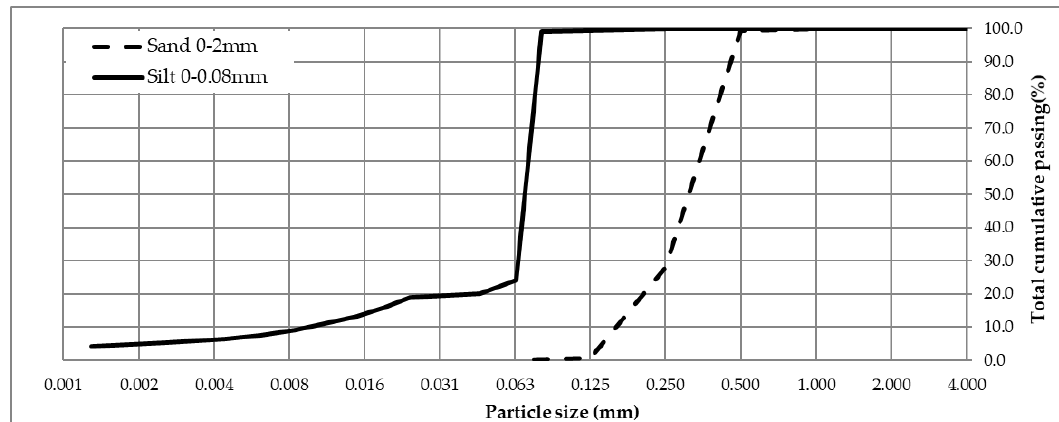
Figure 4. The grain size distribution of used clogging agent.